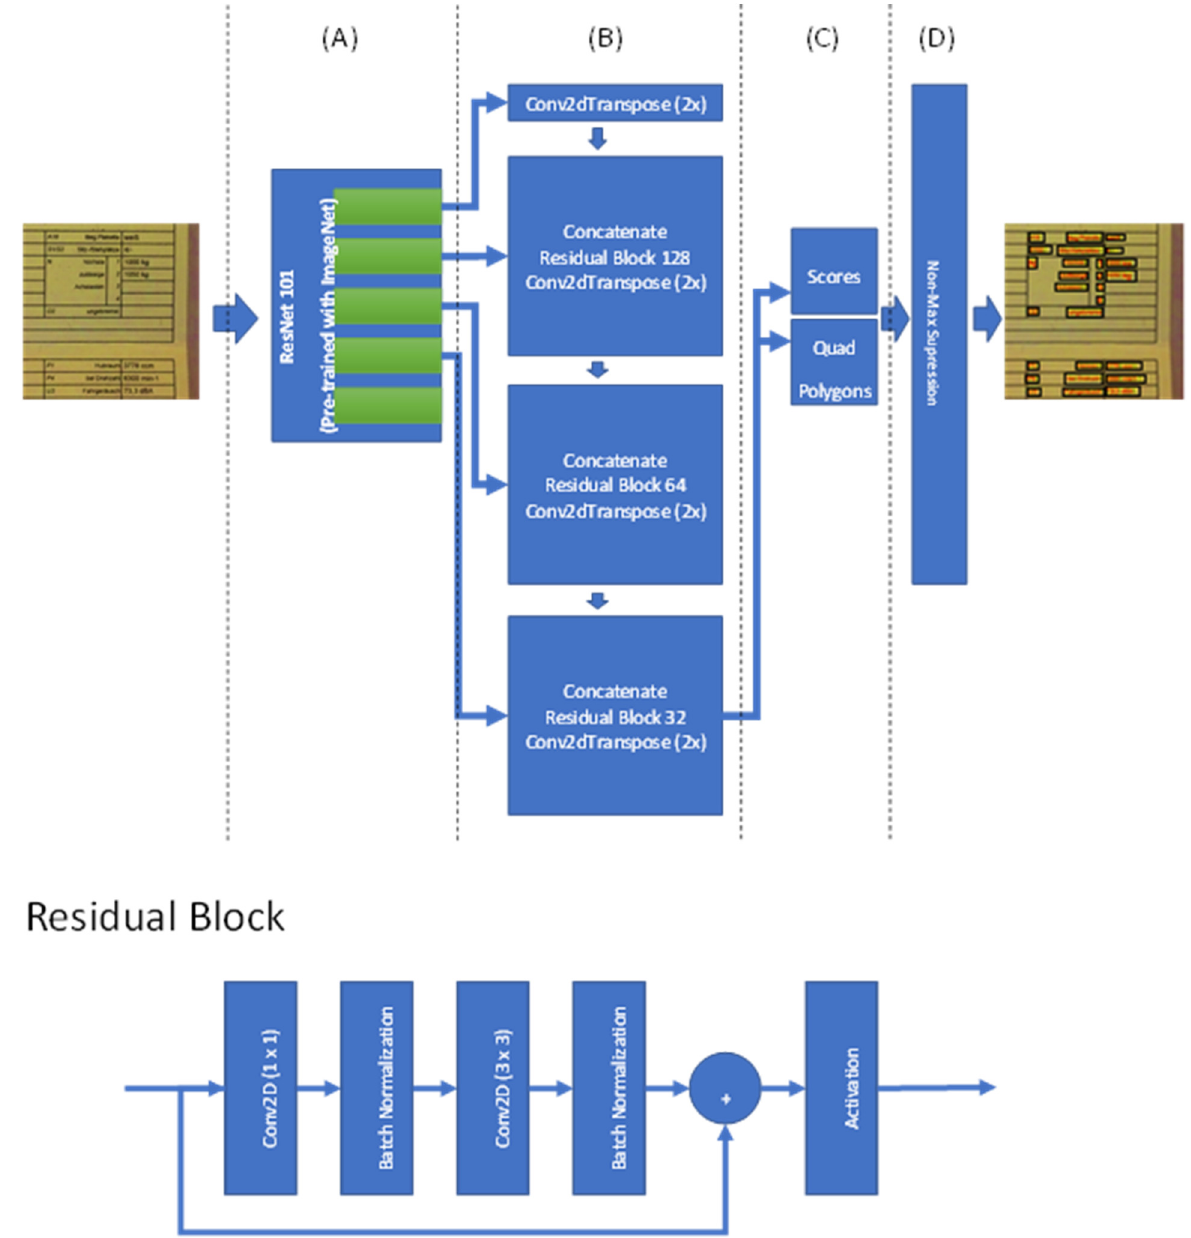
Figure 5. Our detailed architecture for Module 1 indicated in Figure 4. The document detection model contains four parts or sections: ( A ) Feature extraction using pre-trained ResNet 101; ( B ) feature fusion layers using concatenation to merge results and process them using residual blocks; ( C ) output layers, which contain the score values and quad polygons of boundary boxes; and ( D ) a non-max suppression layer.